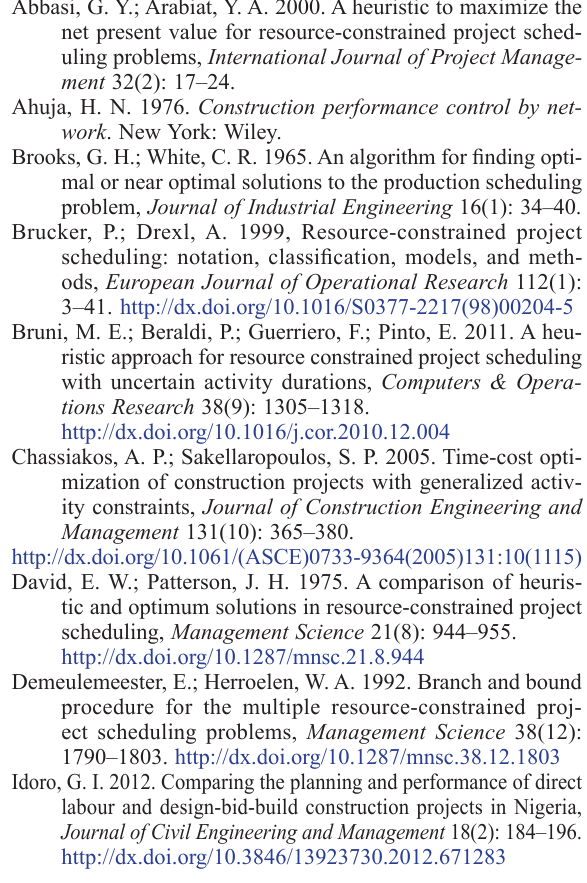
Fig. 4. The estimated values for project time as per the LFT priority rule in testing set